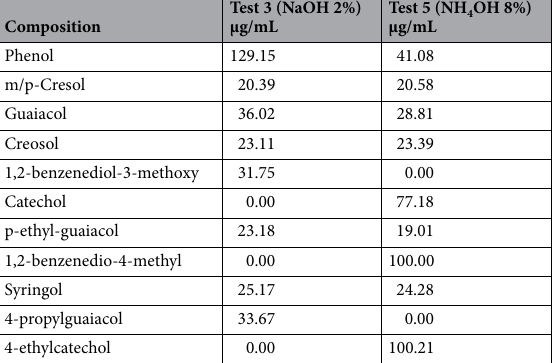
Table 4. Comparison in the composition of light oils obtained in test 3 and in test 5.